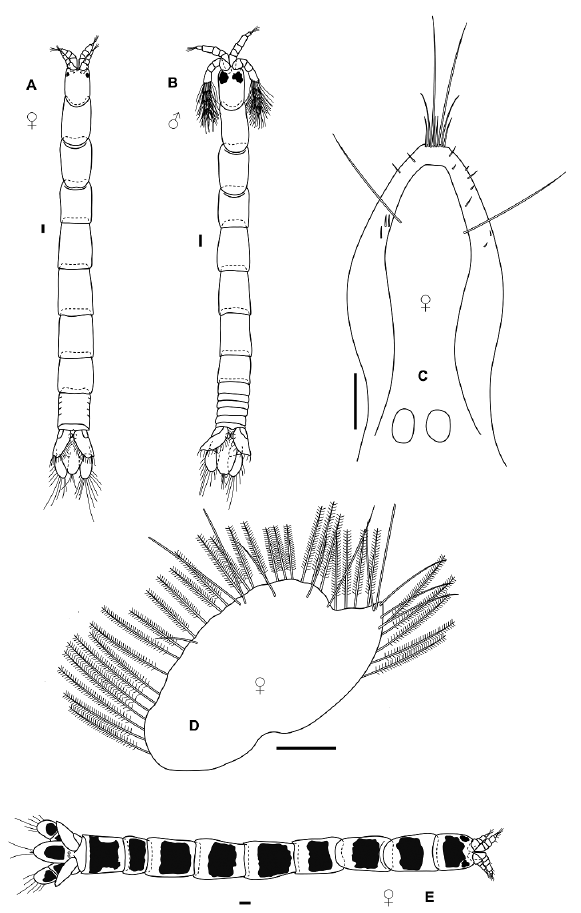
Figure 1. A–D. Apanthura pariensis. A. female. B. male. C. pleotelson. D. uropodal exopod . E. Mesanthura quadrata . All scales represent 0.1 mm.